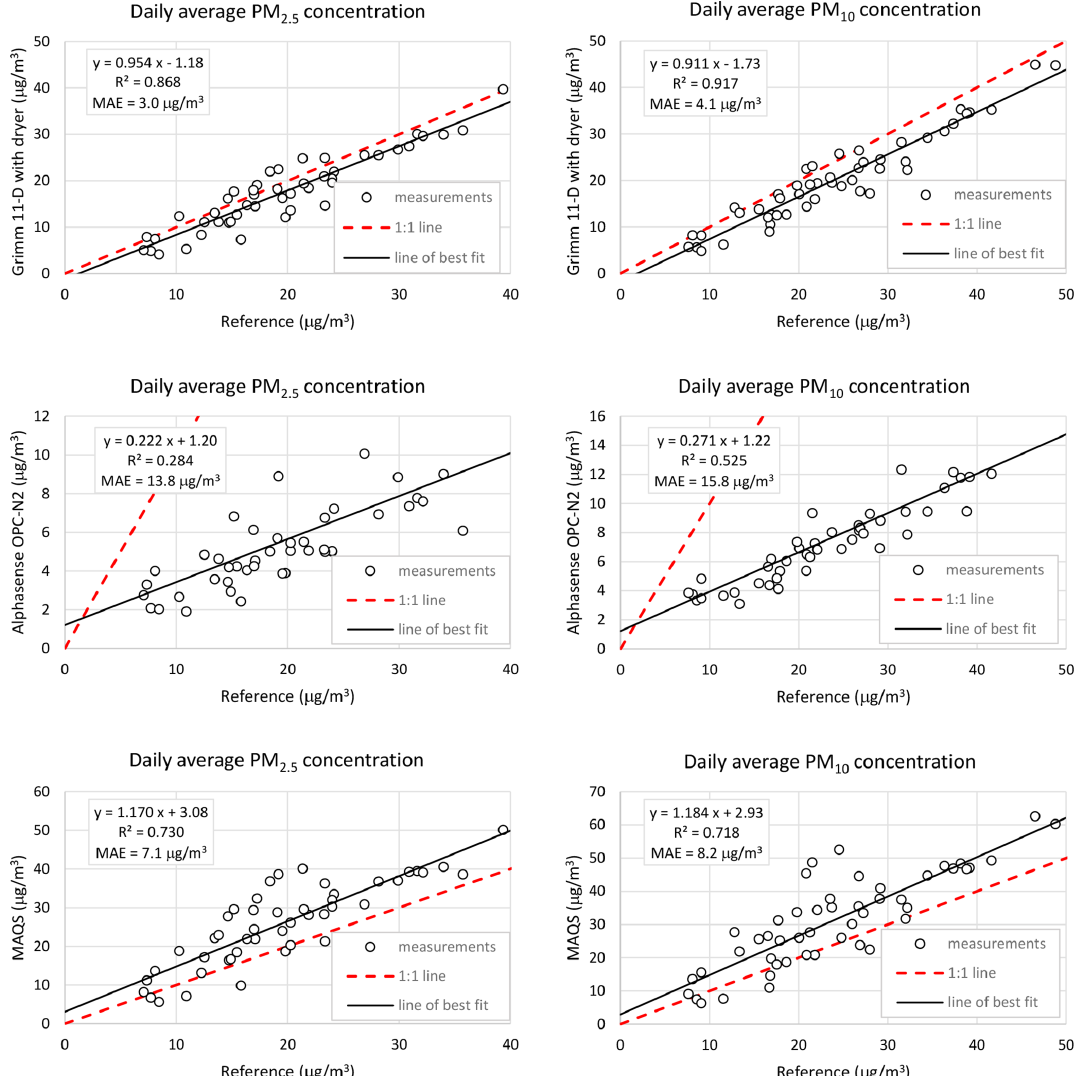
Figure 6. OPS performance during the period of mild pollution (13 March 2020–4 May